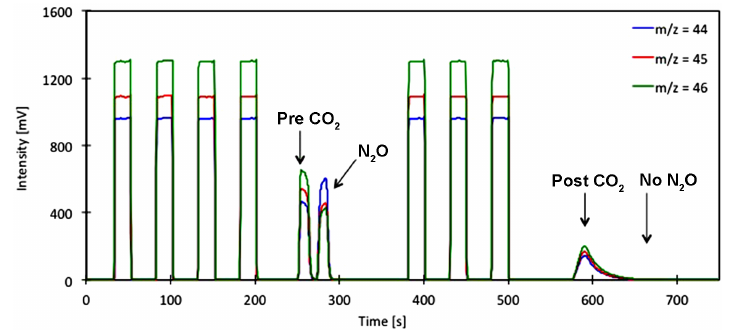
Figure 6. IRMS chromatogram demonstrating the separation of N 2 O from CO 2 on the GC column and the absence of an N 2 O peak after the hot CuO / Ni isotope exchange unit. The artificially prepared mixture of N 2 O and CO 2 was injected to the analytical system following the procedure described in Sect. 2.4.2. In order to observe the N 2 O peak the fifth working RefCO 2 peak was omitted in the chromatogram and the measurement time was extended to 750s.